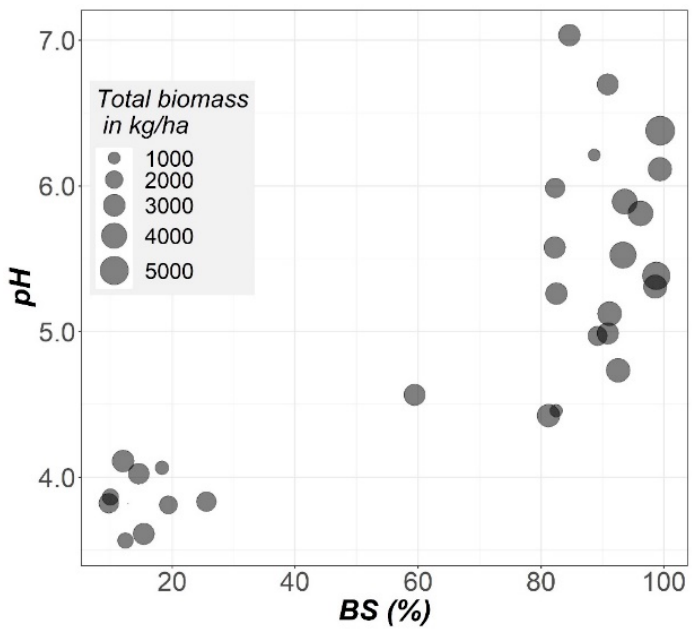
Figure 6. Relationship between soil pH, base saturation of the effective cation exchange capacity (BS) and total rye biomass.